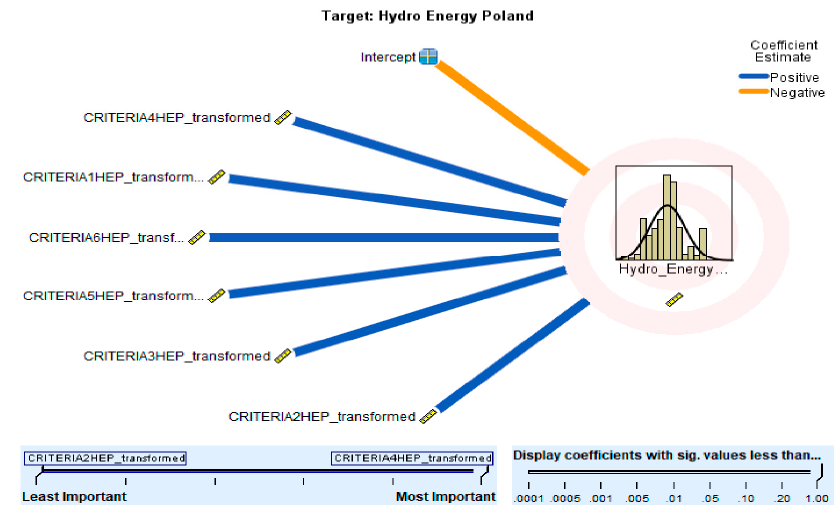
Figure 10. HE Poland GCV Criteria Source: ALM Analysis SPSS by Author.